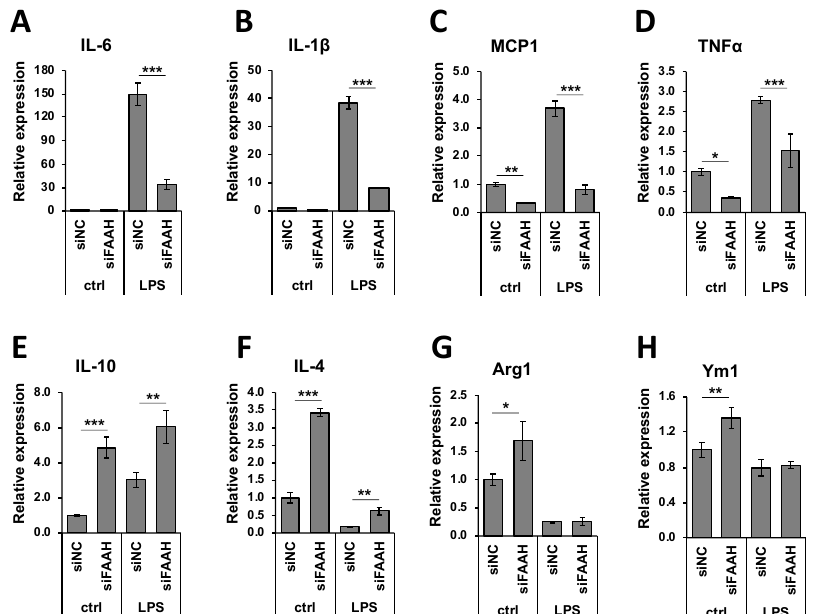
Figure 9. Expression of pro- and anti-inflammatory markers in FAAH knockdown cells. Transfected cells with siRNA were treated with LPS for 8 h and total RNA was collected. Total RNA was used for qRT-PCR to assess expression of the pro-inflammatory cytokines, IL-6 ( A ), IL-1 β ( B ), MCP1 ( C ), and TNF α ( D ), as well as the anti-inflammatory markers, IL-10 ( E ), IL-4 ( F ), Arg1 ( G ), and Ym1 ( H ). Data are presented as means ± S.D. (n = 3) determined by two-way ANOVA. *, **, and *** denote p < 0.05, p < 0.01, and p < 0.001,